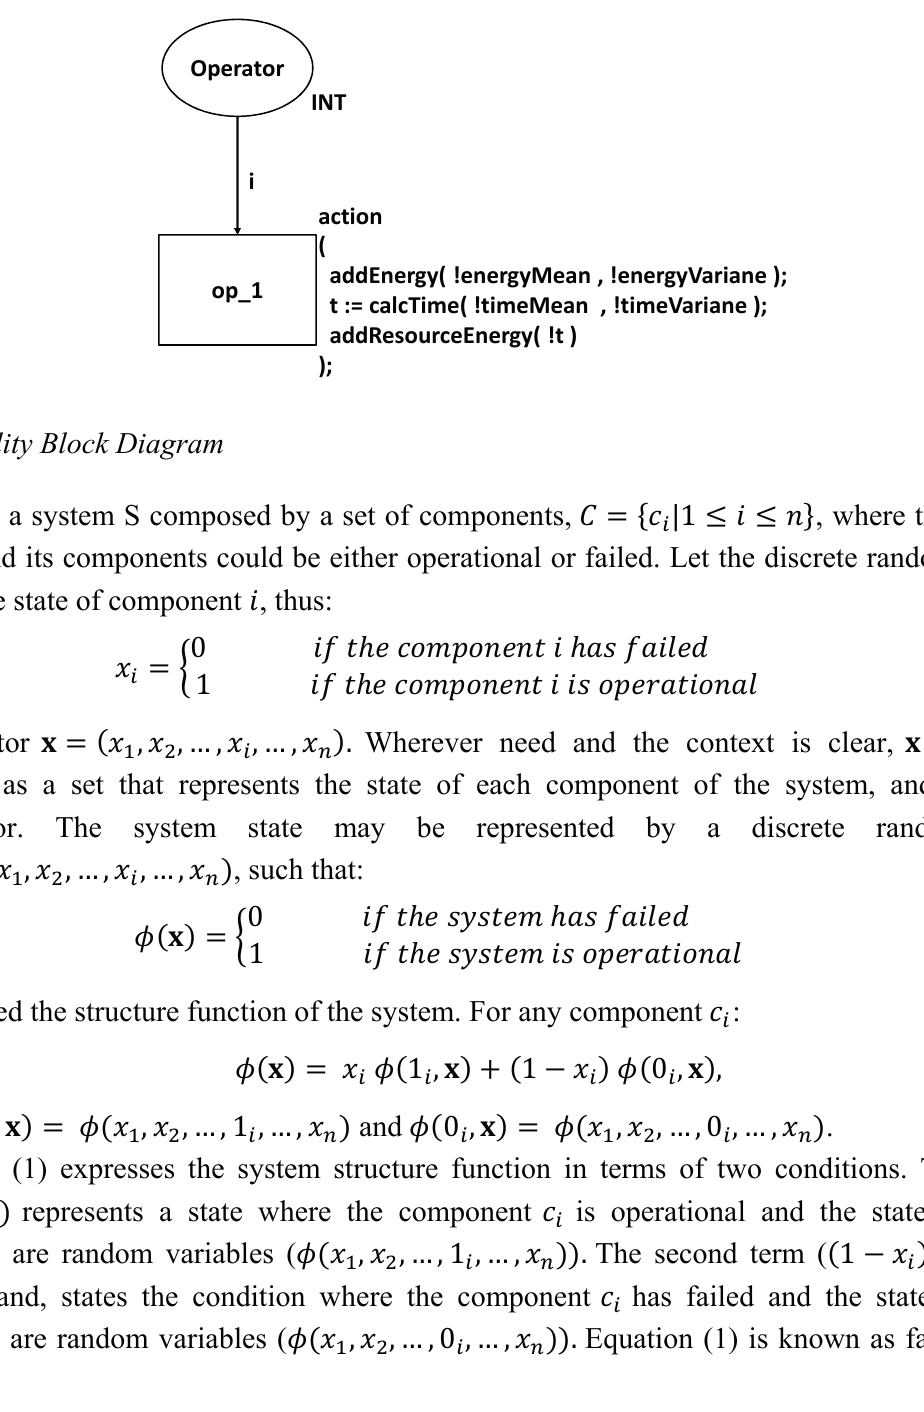
Figure 3. Power consumption model of the nesC assignment